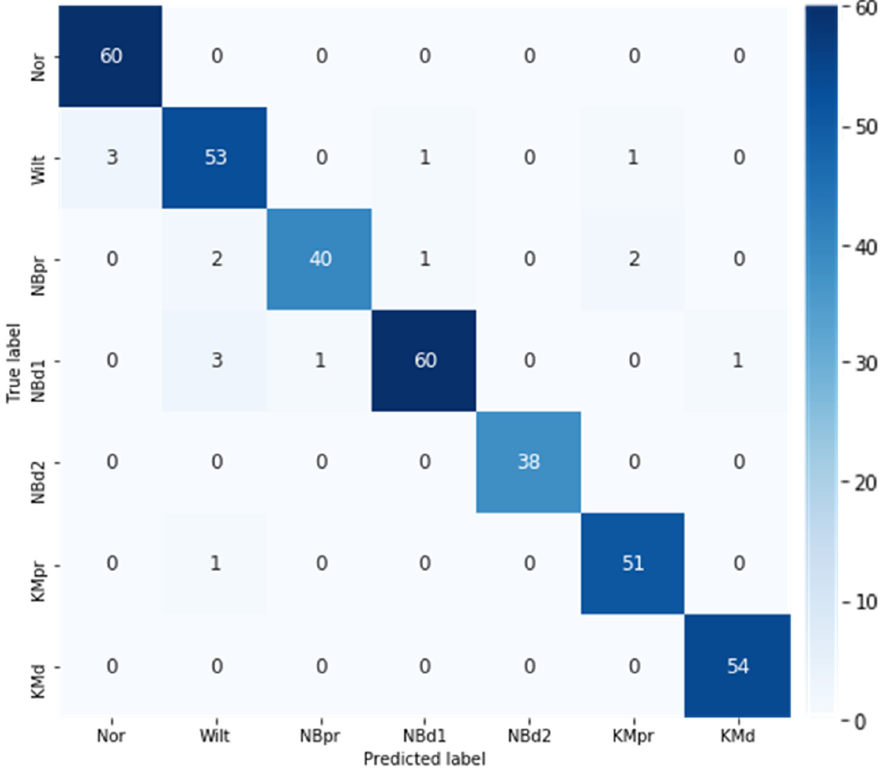
Figure 10. Test set confusion matrix for the RMSProp optimizer model.